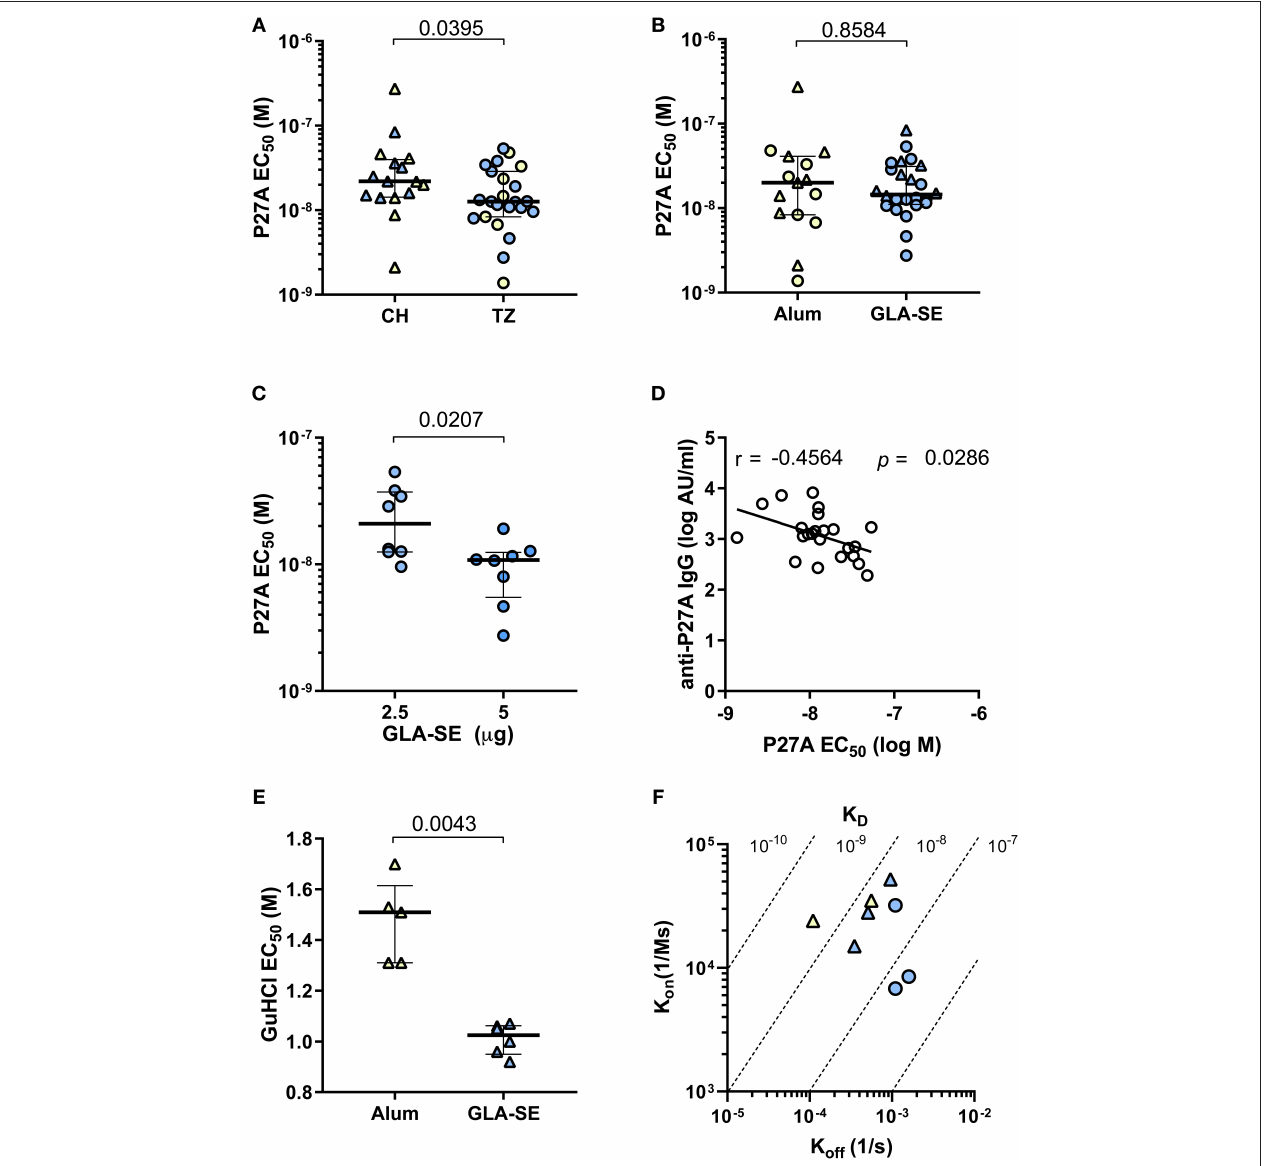
FIGURE 4 | Relative affinity and avidity of specific IgG to P27A at Day 84 in Phase 1a and 1b. Strength of the binding of specific IgG to P27A was evaluated at day 84 for all volunteers (CH and TZ) by competition ELISA using soluble P27A as competitor (A–C) or guanidium chloride GuHCl (E) . Results are expressed as EC 50 . (A) Comparison of relative antibody affinity for P27A in pre-exposed and unexposed subjects, from TZ (3 groups, n = 23) and CH (2 groups, n = 16), respectively. (B) Comparison of relative antibody affinity for P27A in each adjuvant group, Alum ( n = 16) and GLA-SE ( n = 23). (C) Comparison of relative antibody affinity for P27A in each TZ-GLA-SE dose group, 2.5 or 5ug. (D) Correlation between anti-P27A IgG titer (log AU/mL) and affinity (log M) in pre-exposed TZ subjects, n = 23. Pearson r and p -values are indicated. (E) Comparison of antibody avidity for P27A in unexposed volunteers grouped by adjuvant type, Alum ( n = 5) and GLA-SE ( n = 5). (F) Antibody avidity for P27A in eight samples from TZ-GLA2.5/50 ( n = 3, blue circles), CH-GLA2.5/50 ( n = 3, blue triangles), and CH-Alum/50 ( n = 2, yellow triangles). Antibody avidity was determined by SPR with kinetic constants K on (association) and K off (dissociation) and equilibrium K D = K off /K on . (A–C,E) Lines indicate medians and quartiles, p -values of Mann-Whitney tests are indicated. TZ subjects, circles; CH subjects, triangles; Alum, yellow symbols; GLA-SE, blue